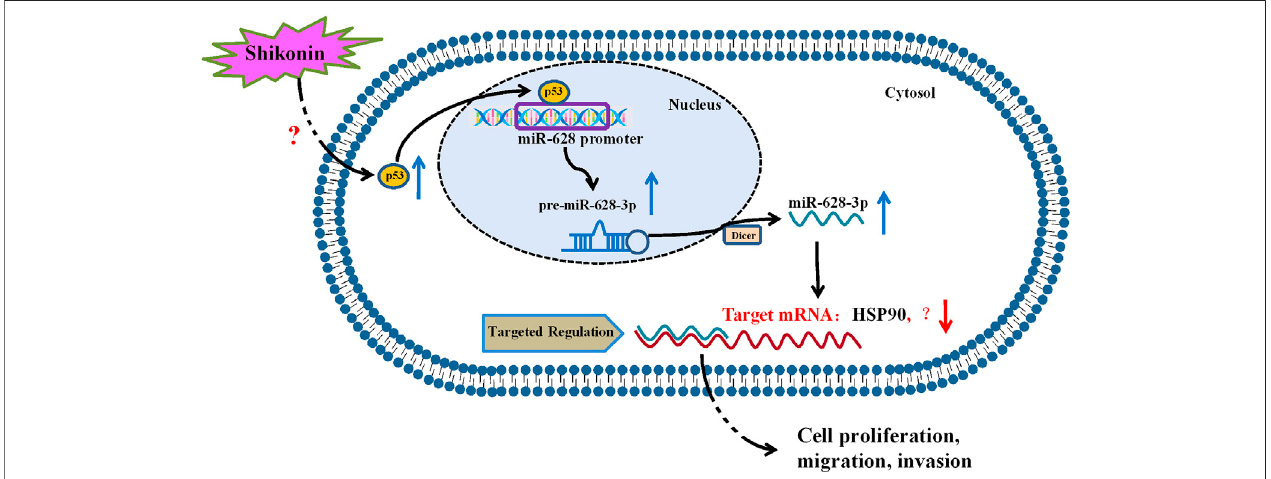
FIGURE 8 | Proposed mechanism of SHK inhibiting cell growth and inducing cell apoptosis in non – small cell lung cancer by regulating p53/miR-628-3p